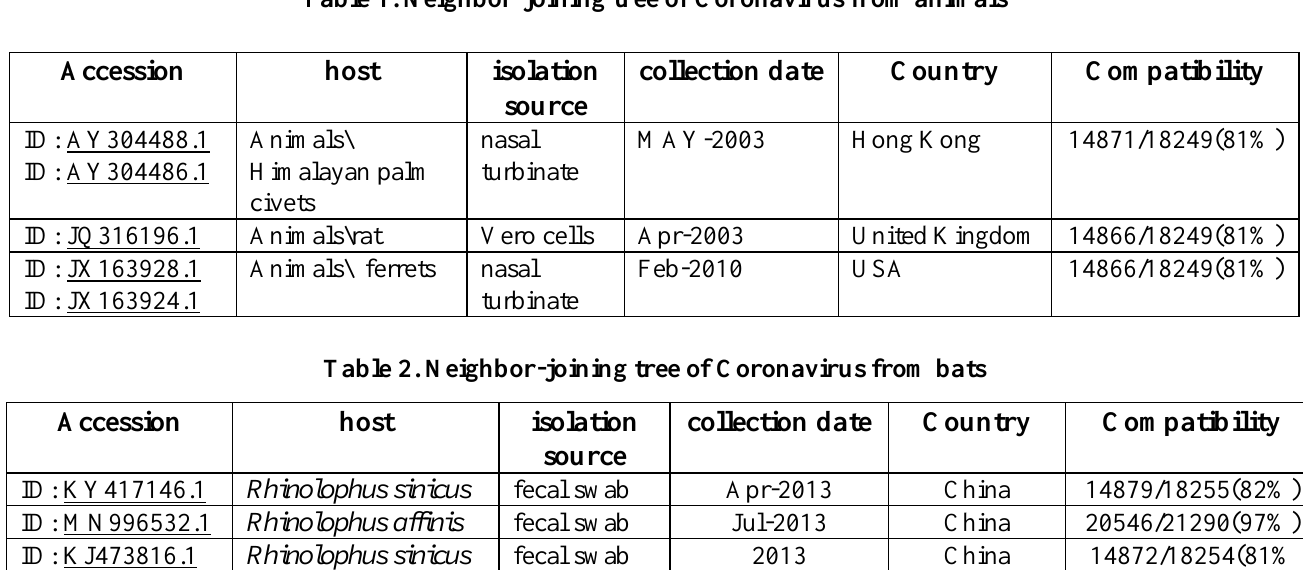
Table 1. Neighbor-joining tree of Coronavirus from animals